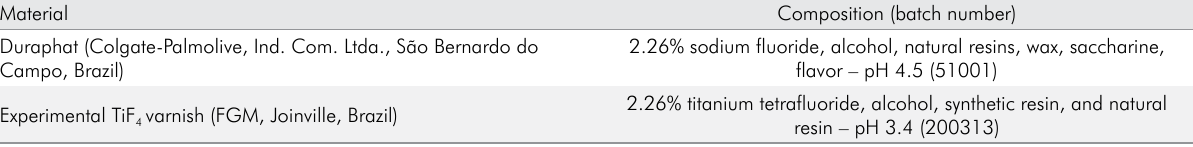
Table 1. Composition of fluoride varnishes tested in the study.